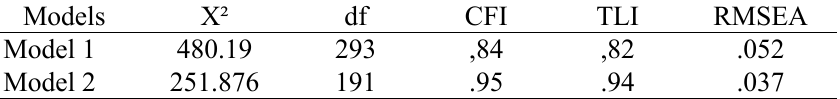
Results for the two models